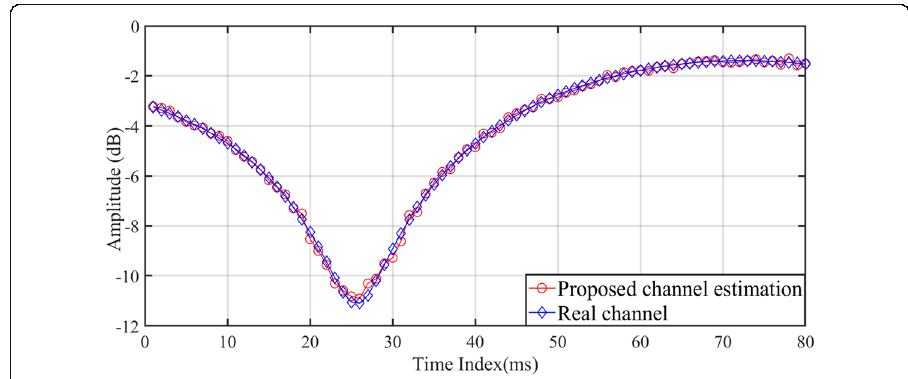
Fig. 18 Channels tracking performance for the time-varying